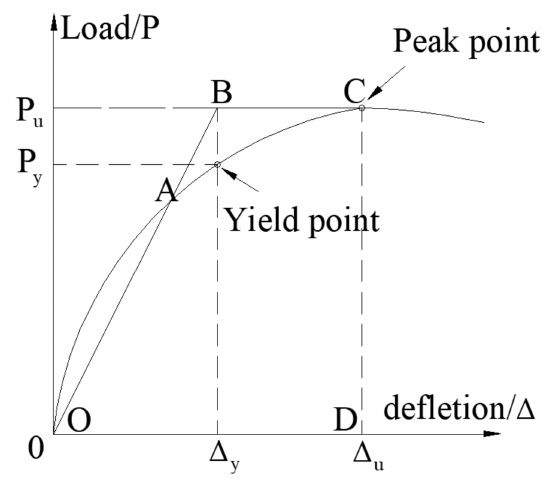
Figure 3. Equal energy method (derived from